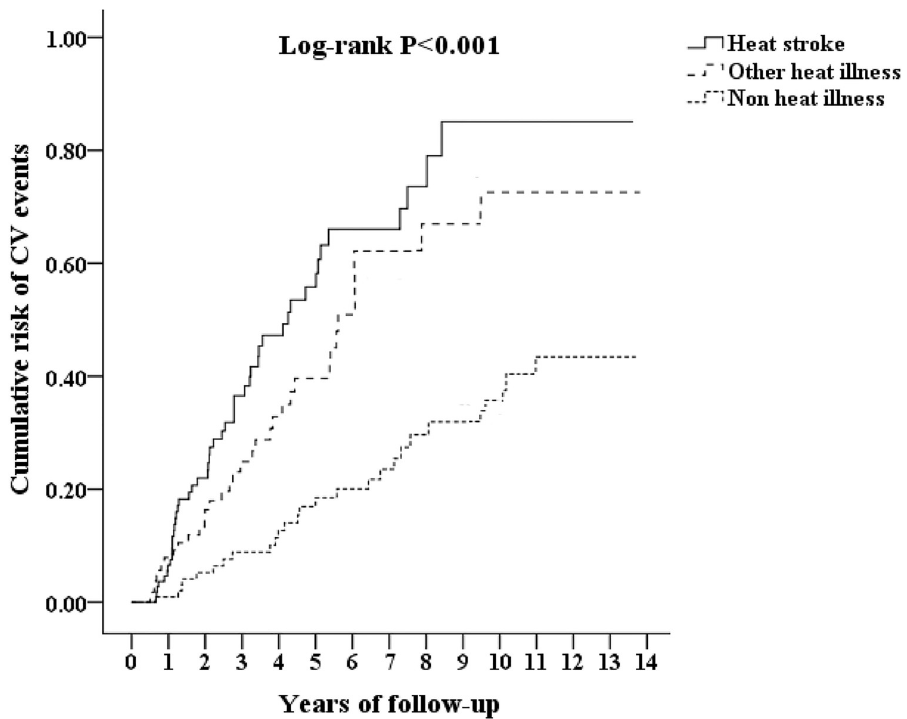
Fig 2. Comparison of the cumulative incidence of cardiovascular diseases among patients with heat stroke, other heat-related illnesses and Non-heat-related illnesses. CV events = cardiovascular events. � p values < 0.05 were considered statistically